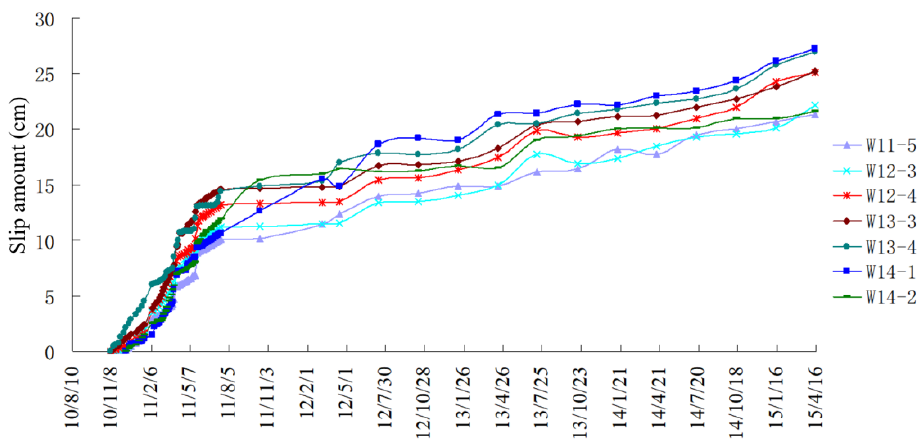
Figure 12. Multipoint displacement meter monitoring displacement–time curve of each measurement point of fault F3.